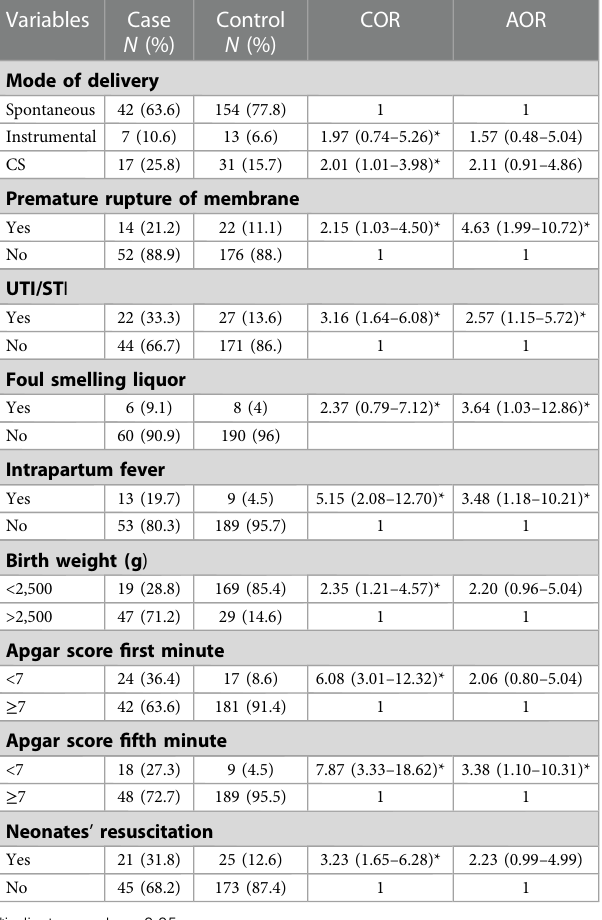
TABLE 4 Multivariable logistic regression analysis of risk factors of neonatal sepsis at Hawassa University Comprehensive Specialized Hospital and Adare General Hospital, Hawassa city, Ethiopia, 2018.